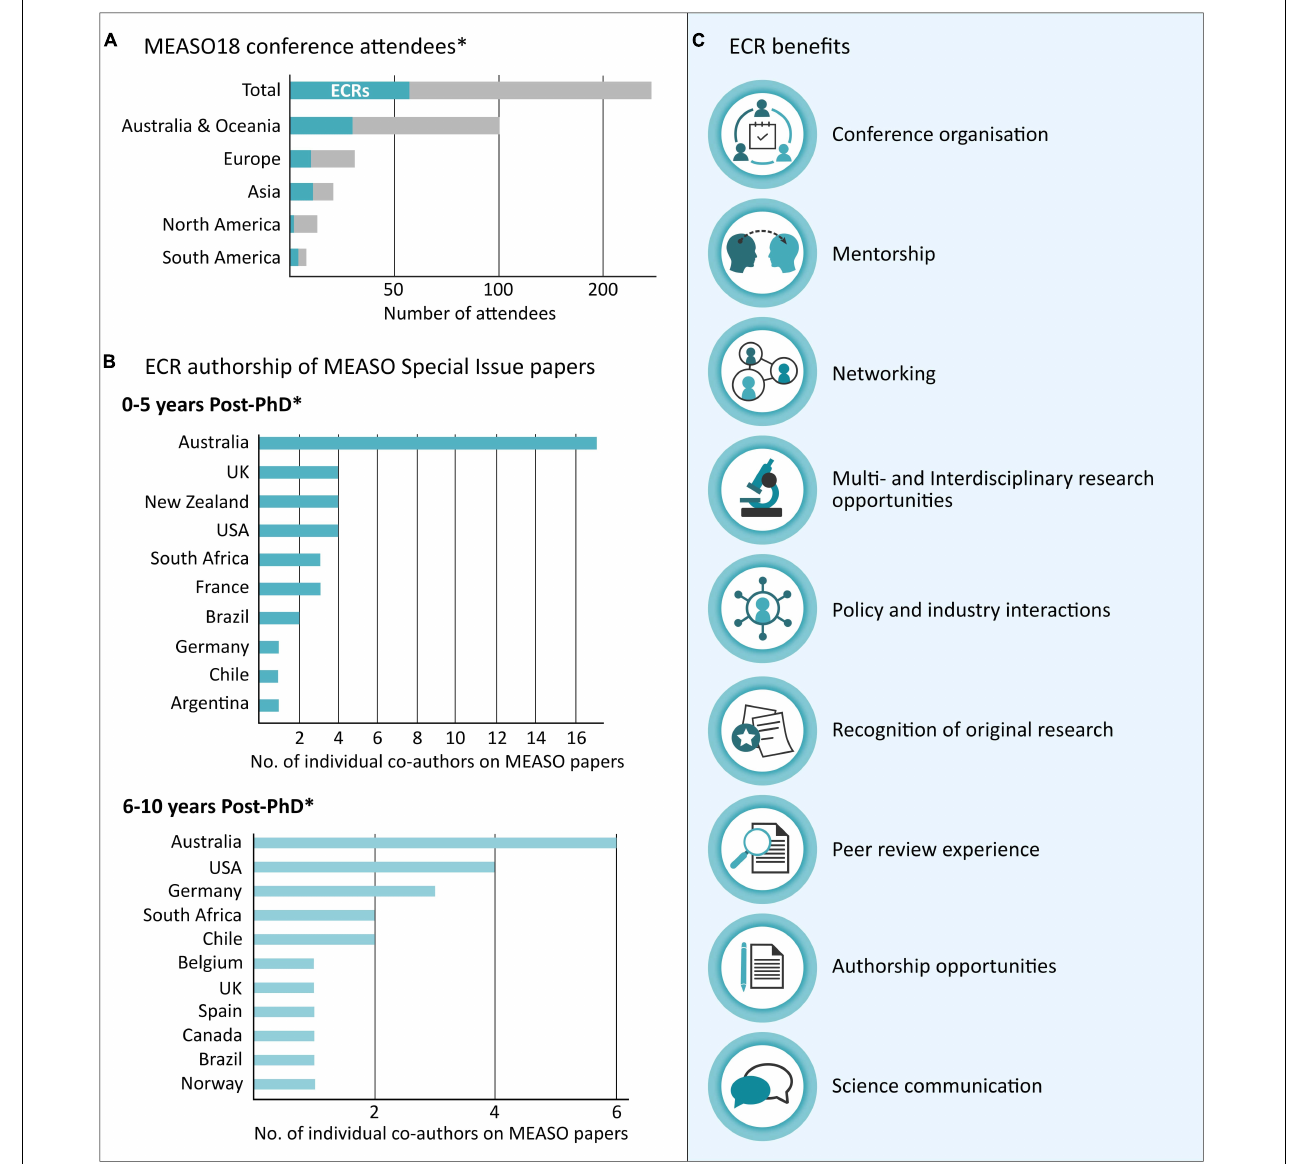
FIGURE 1 | Early career researcher (ECR) participation and resulting benefits from their involvement in the Marine Ecosystem Assessment for the Southern Ocean (MEASO). (A) attendance at the MEASO2018 conference by continent (B) ECR and mid-career researcher (MCR) authorship of MEASO Research Topic papers by country (C) a list of benefits and opportunities created for ECRs during the MEASO project. * Continents/countries represent institutional affiliation not nationality of individuals. ECRs are defined as researchers being within 5 years of finishing a Ph.D. or other terminal degree, which is the definition used by the Scientific Committee on Antarctic Research and MCRs as those within 5–10 years of their Ph.D. Data used in this figure is supplied in the Supplementary Material .